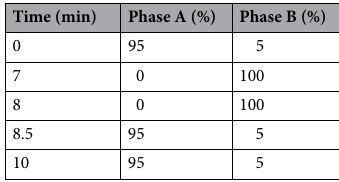
Table 1. Gradient mode.